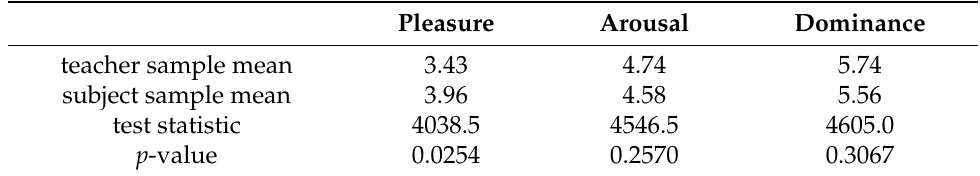
Table 2. Comparing the distribution of PAD values for teacher and subject opinions—mean values and results of Mann–Whitney